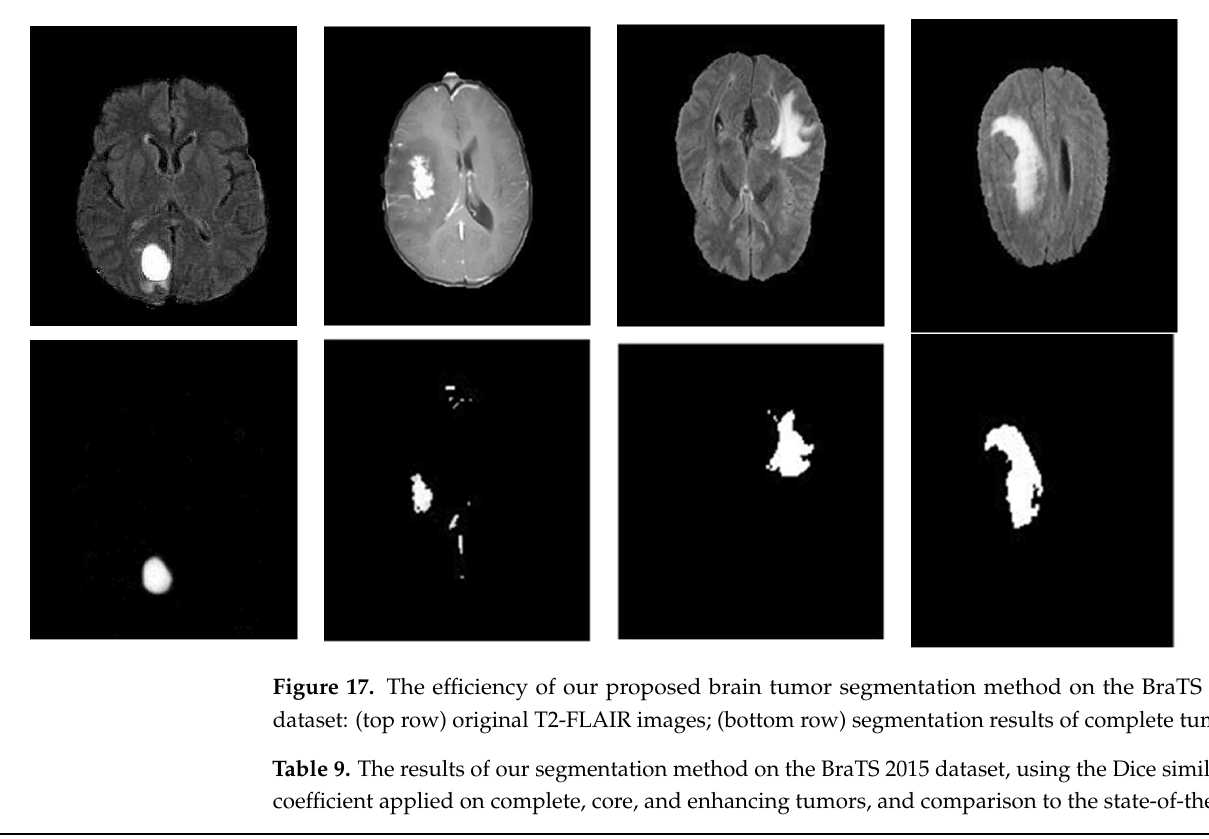
Figure 16. The three modalities of tumor regions: complete, core, and enhancing tumors.